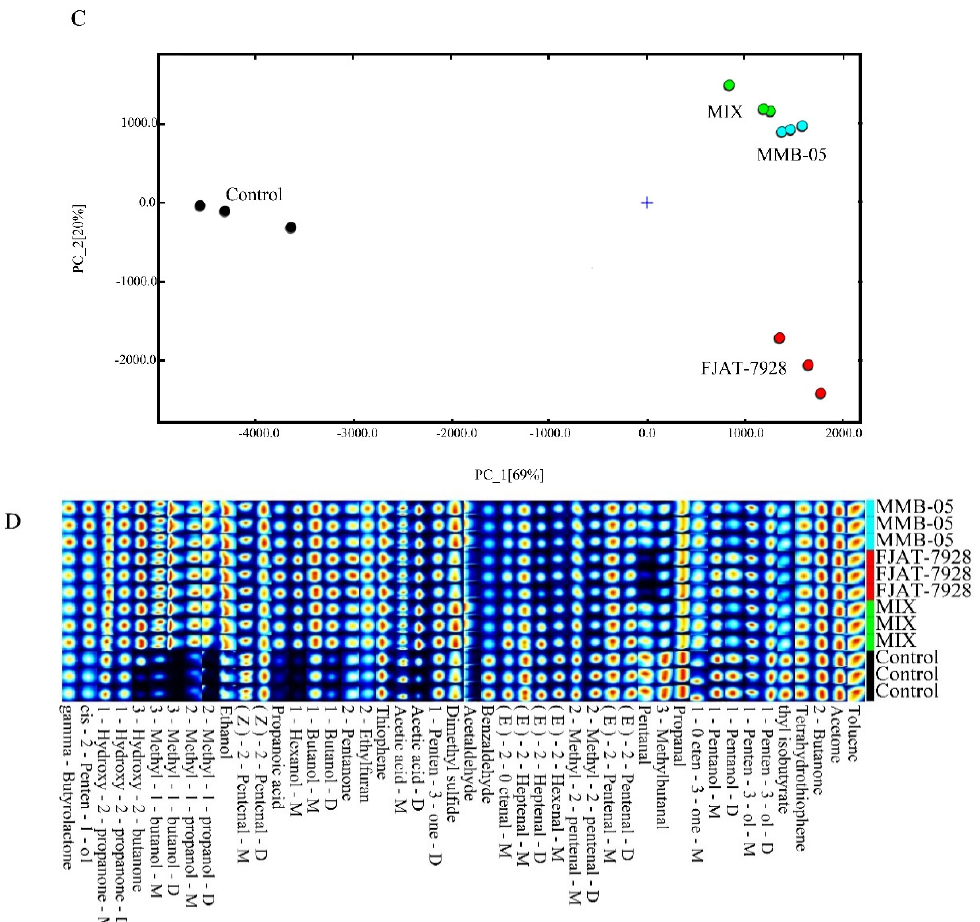
Figure 9. The volatile organic compounds analysis of 72 h fermented P. yezoensis sauce by GC-IMS. 3D-topographic top view plot ( A ); difference map of 3D-topographic top view plot ( B ); PCA score chart ( C ); fingerprint spectrum of some of the volatile organic compounds ( D ).